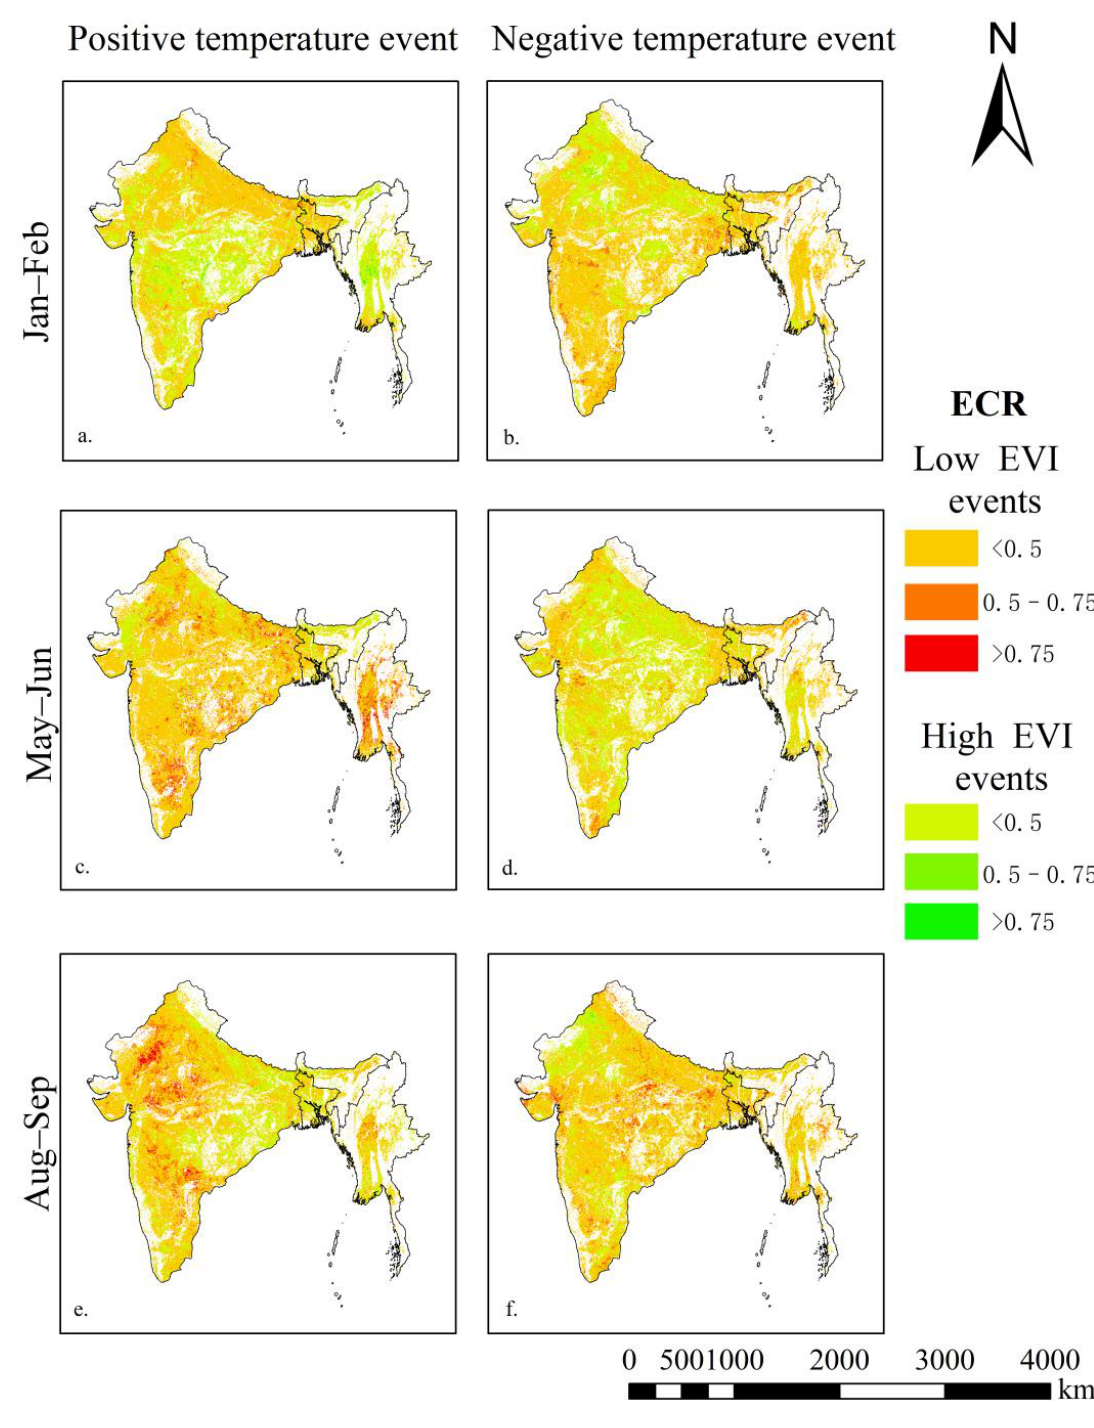
Figure 6. Spatial patterns of significant event coincidence rates (SCRs) between different combinations of low and high temperature and EVI extremes during the three considered time periods (( a , c , e ) and ( b , d , f ) represent extreme EVI under extreme high and extreme low temperatures in Jan-Feb, May-Jun and Aug-Sep, respectively, with red representing extreme low EVI values and green representing extreme high EVI values).